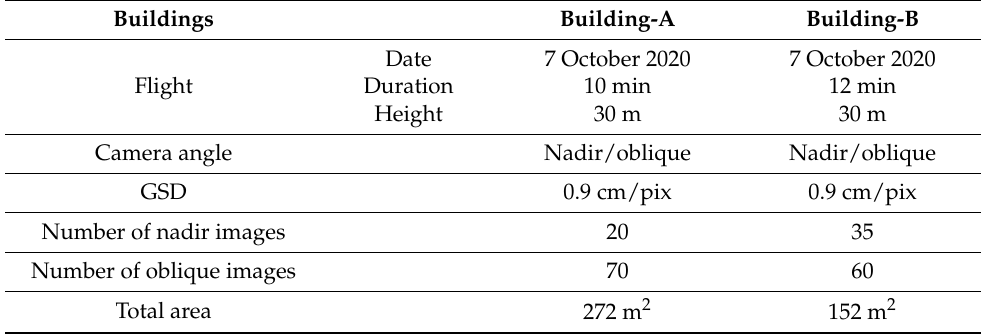
Table 1. Flight planning parameters for UAS data acquisition.